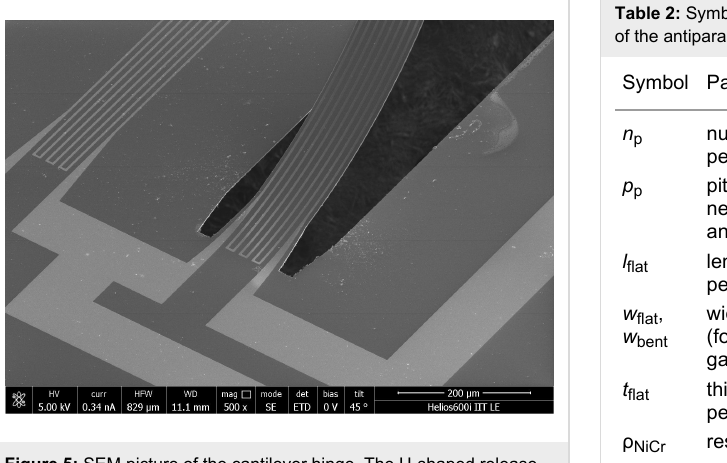
Figure 5: SEM picture of the cantilever hinge. The U-shaped release pattern and the micro strain gauges including connection wires are visible.